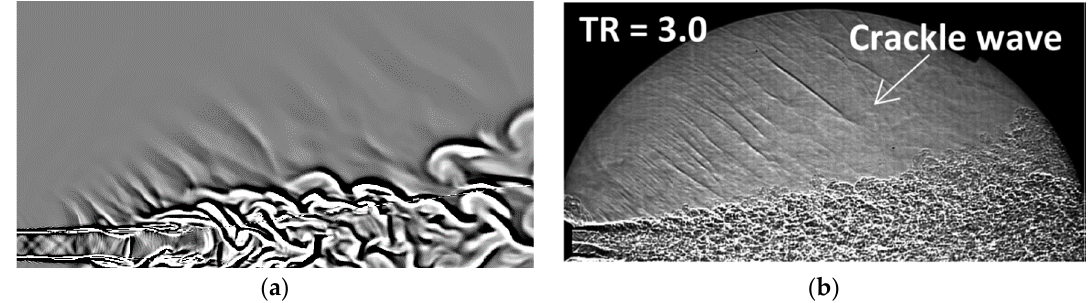
Figure 25. ( a ) Instantaneous numerical shadowgraph, ( b ) Instantaneous Schillerian from experimental measurements (Ref. [35]).